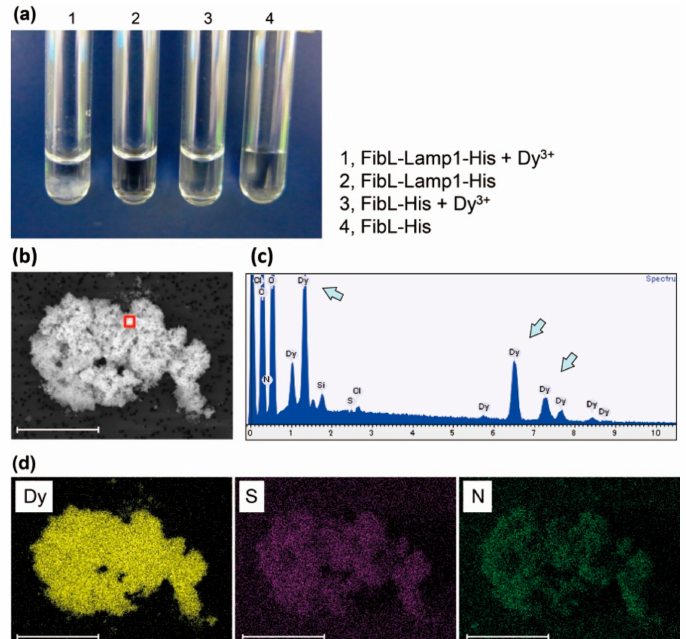
Figure 2. Dy 3 + recognition with purified FibL-Lamp1-His protein. ( a ) Optical image of precipitation induced with protein adding. ( b ) SEM image of precipitation. Scale bar, 100 µ m. ( c ) EDX spectrum. The red frame area in the SEM image of (b) was analyzed. Each arrow indicates the spectrum of Dy. ( d ) Elemental mapping of SEM image (Dy, dysprosium; N, nitrogen; and S, sulfur). Scale bar, 100 µ